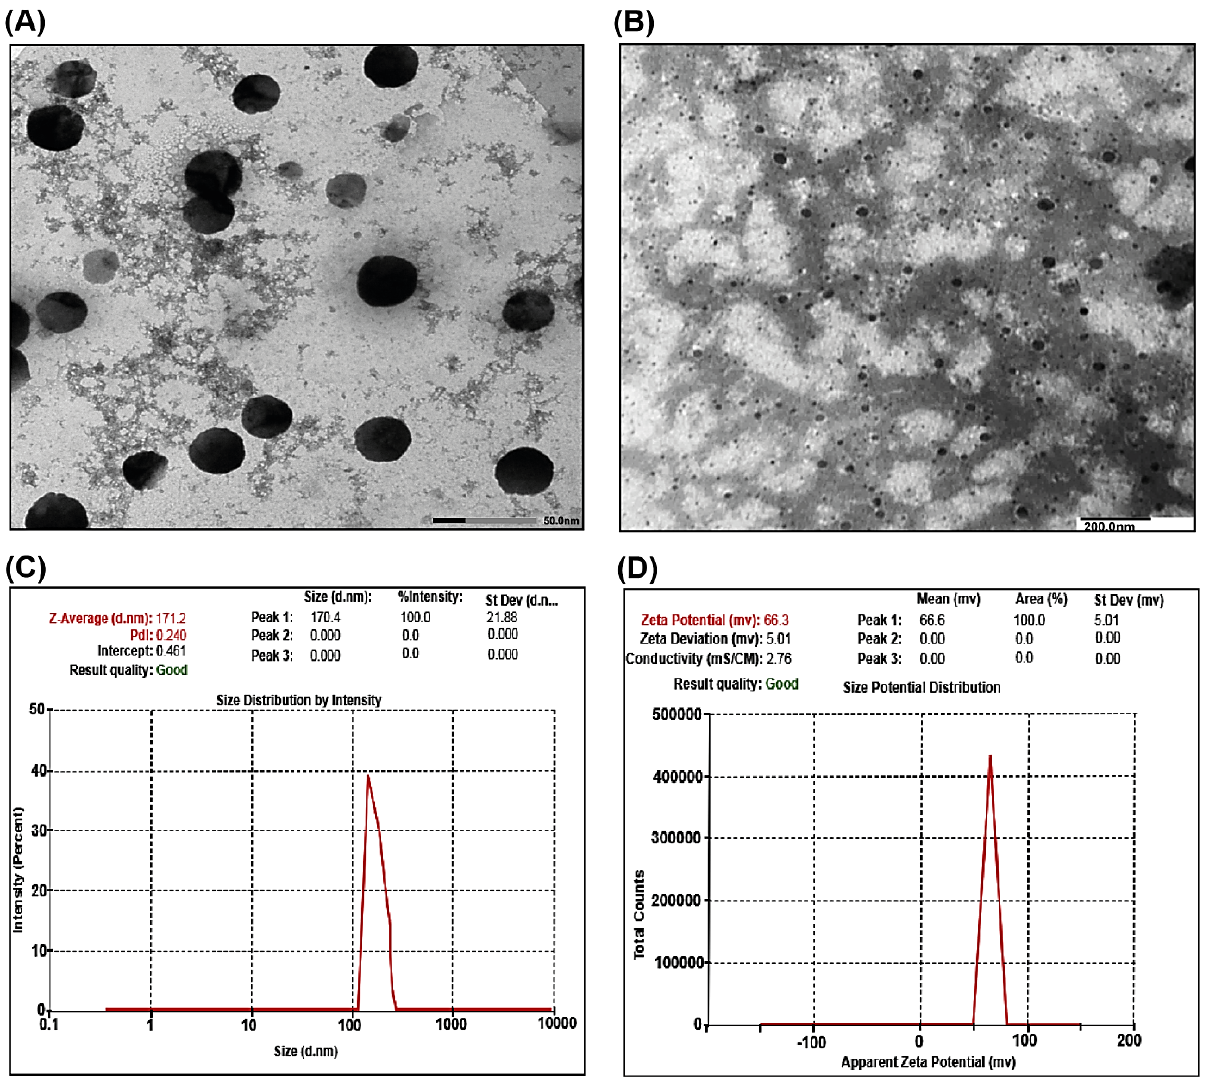
Figure 2. Transmission electron microscopy images of SCNPs: ( A , B ) average particle size around 78 ± 6 nm; ( C ) particle size distribution for synthesized SCNPs by dynamic light scattering shows the average size at 170.4 nm; ( D ) zeta potential of SCNPs shows stable positive charge at +66.3 mV.